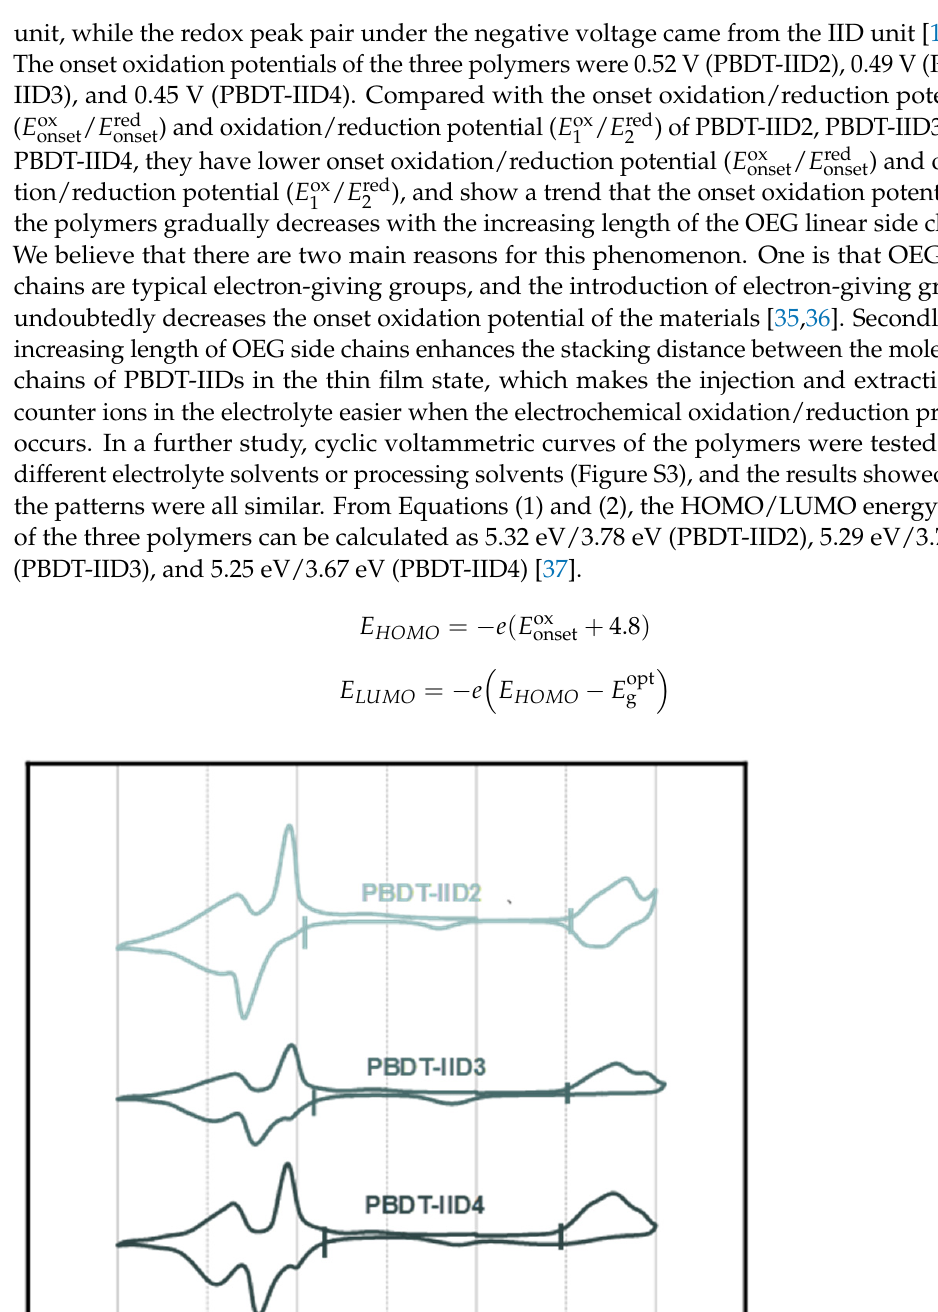
Table 3. The electrochemical properties of the PBDT-IIDs.